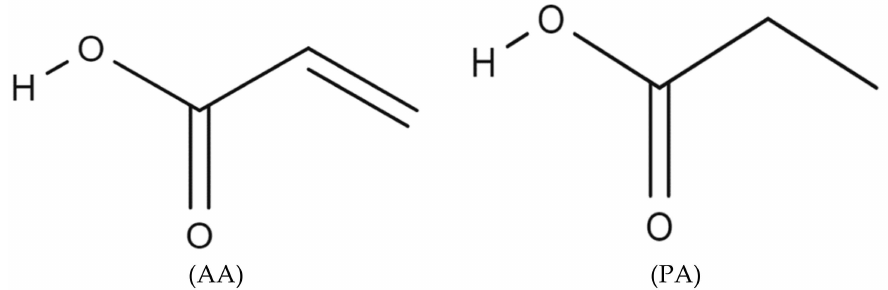
Figure 2. Chemical structures of acrylic acid (AA) and propionic acid